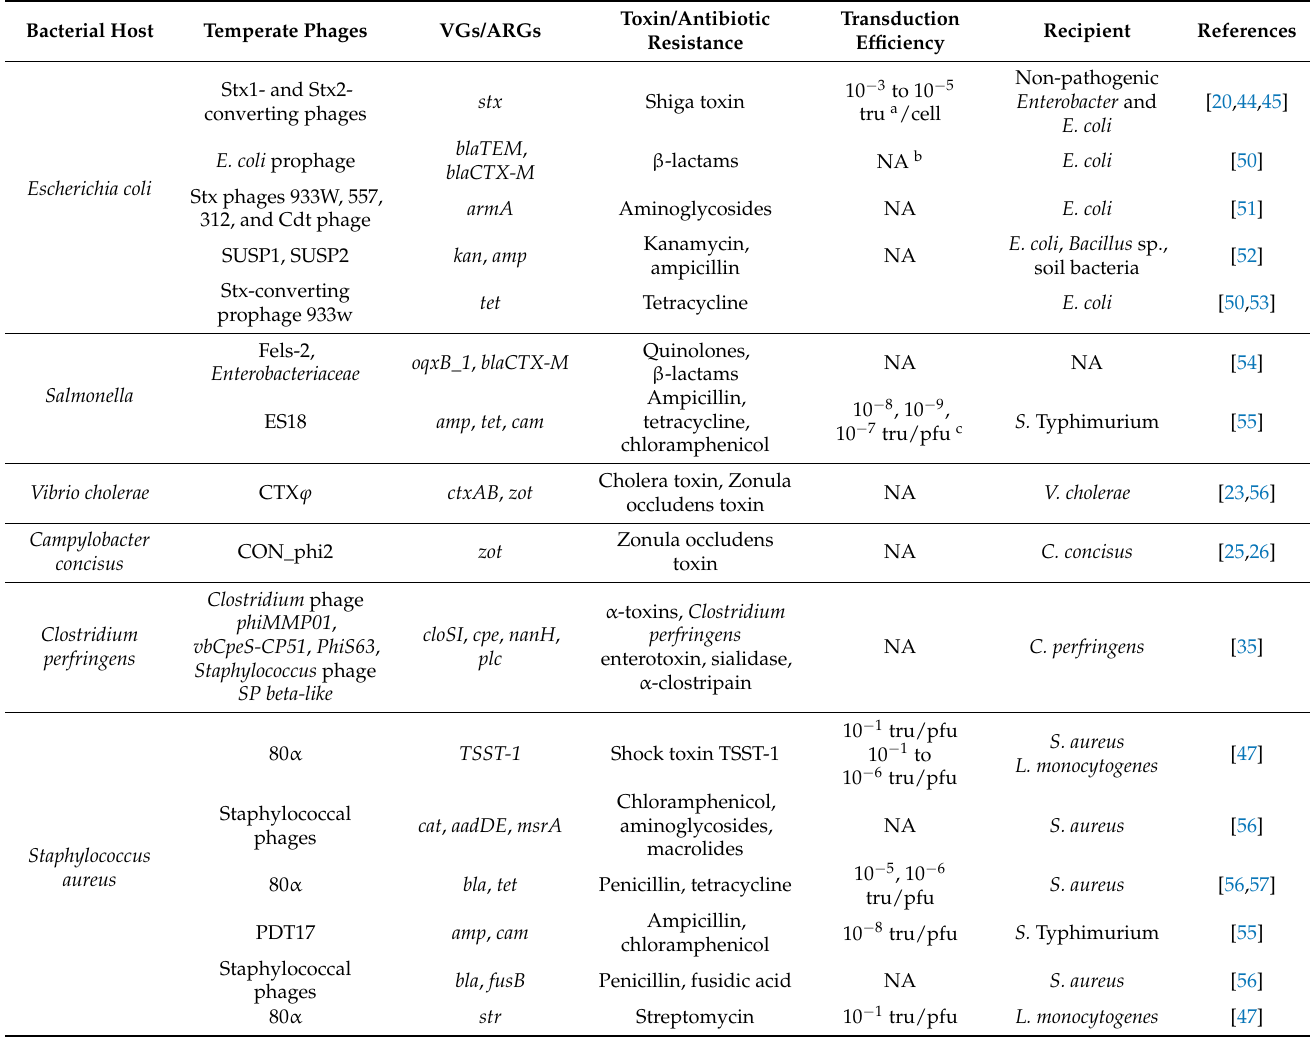
Table 1. Temperate phage-mediated virulent gene (VG) and antibiotic-resistant gene (ARG)